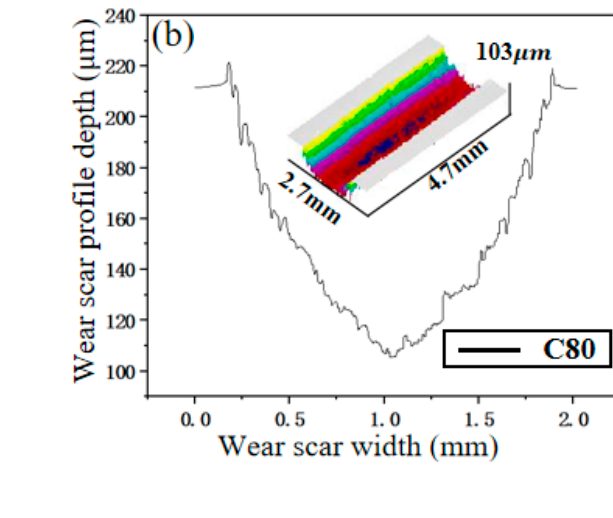
Figure 10. Friction coefficient–time curves of the test specimens.